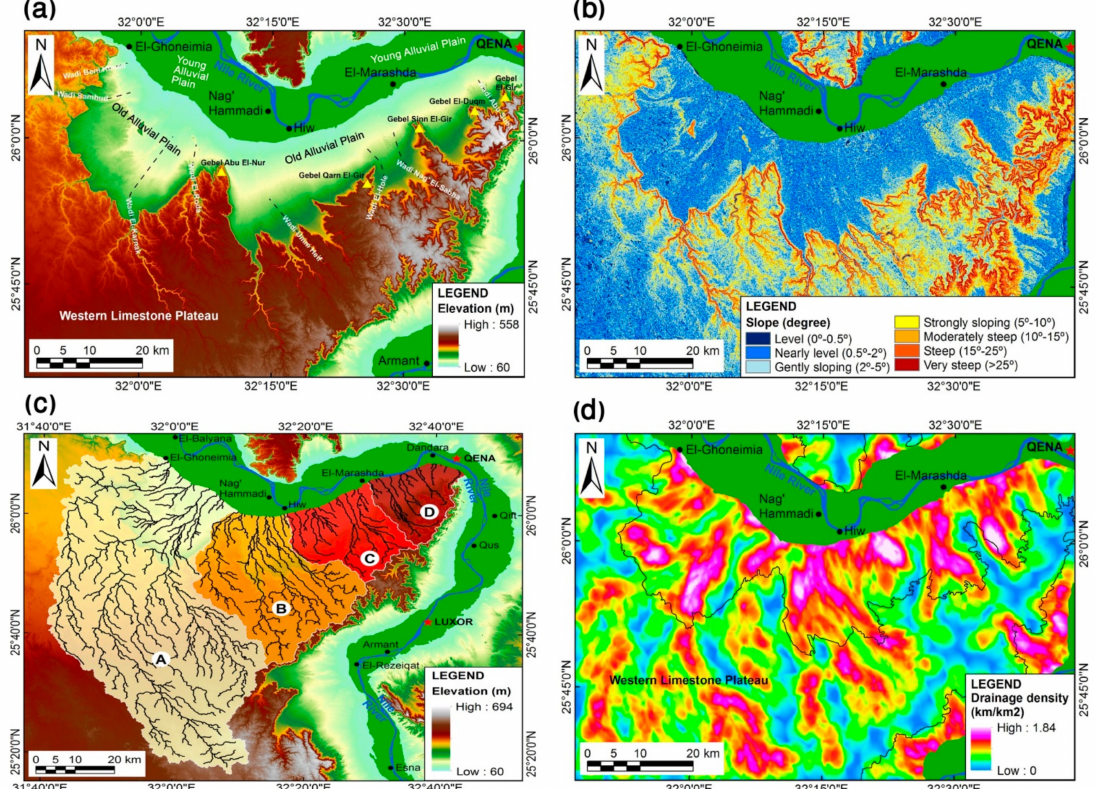
Figure 3. ( a ) SRTM digital elevation model (DEM); ( b ) surface slope; ( c ) watersheds and drainage channels; ( d ) drainage density. The solid green color surrounding the River Nile represents